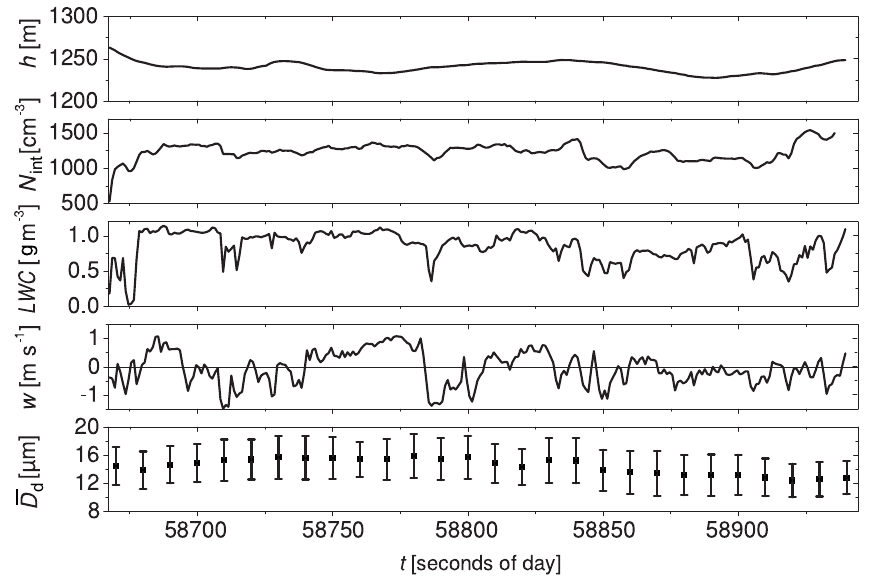
Fig. 4. Time series (1Hz data) of altitude ( h ), interstitial particle number concentration ( N int ), liquid water content (LWC), vertical wind velocity ( w ) and mean droplet diameter ( D d , error bars mark the standard deviation) for 10s long intervals during an approximately 5km long flight leg inside the SC.